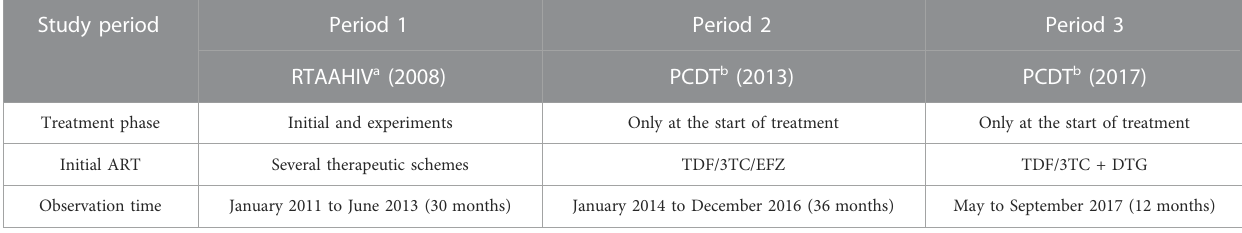
TABLE 1 Database characteristics in each study period. Hospital Universitário de Brasilia, Brasilia, Brazil, 2019. Study